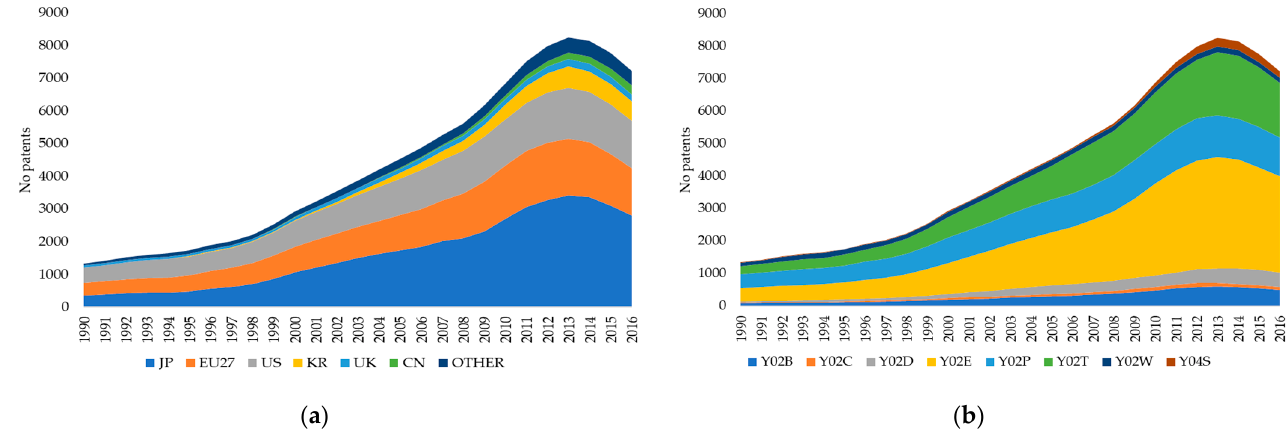
Figure 1. CCMT-TPF trends in absolute values (1990–2016; 5-year MA): ( a ) by country, ( b ) by patent class.